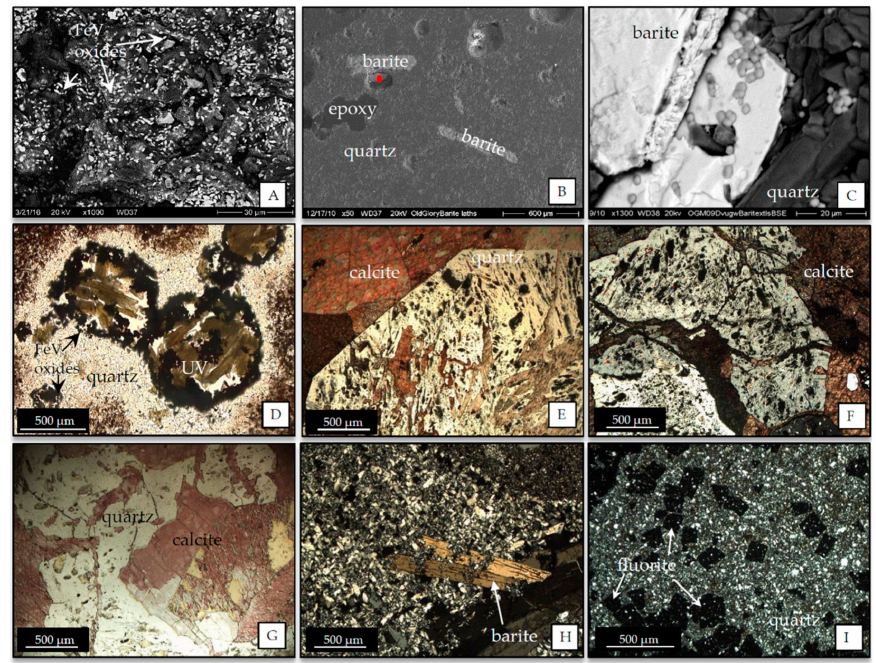
Figure 13. Barite and quartz in the PMD. ( A ) Fe-V oxides with trace amounts of Tl, Pb and Ti in quartz matrix of a THB from the Old Glory mine, PMD, BSE, 1000 × magnification; ( B ) Barite laths in quartz matrix with barite in vug marked by red dot, SEI, 50 × magnification; ( C ) Barite from vug in Figure 13B formed around spherical minerals with Fe, Si, Al, Ba and S, BEI, 1200 × magnification; ( D ) Tyuyamunite or metatyuyamunite crystals in Fe-V oxide lined, bleached circular vugs; ( E ) Sharp euhedral crystal boundary of corroded quartz grain and red stained calcite fill in irregular vugs in quartz, Marie mine, PMD, xpl, white card method; ( F ) Quartz veinlet, micro fractured with mosaic pattern, healed by calcite, Marie mine, PMD, xpl; ( G ) Quartz veinlet, micro fractured with mosaic pattern, healed by red stained calcite, Marie mine, PMD, ppl, white card method ( H ) Grey and white euhedral microcrystalline quartz filling in void space around earlier barite, Swamp Frog mine, PMD, xpl; ( I ) Cryptocrystalline quartz filling in around isotropic fluorite cubes, Dandy mine, PMD,